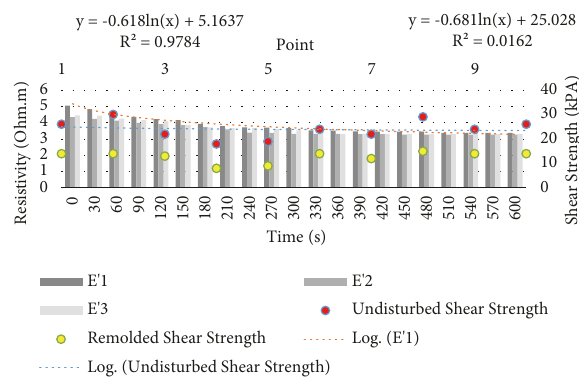
Figure 12: Line 5, in-situ test.